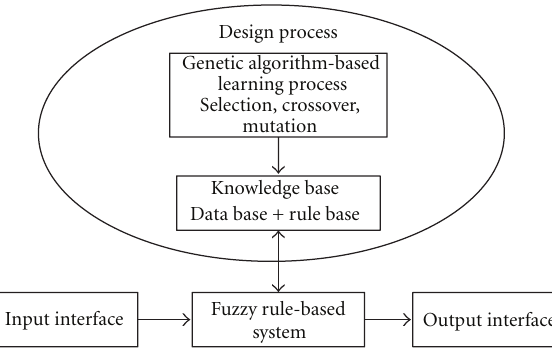
Figure 5: Genetic fuzzy inference system (G-FIS).